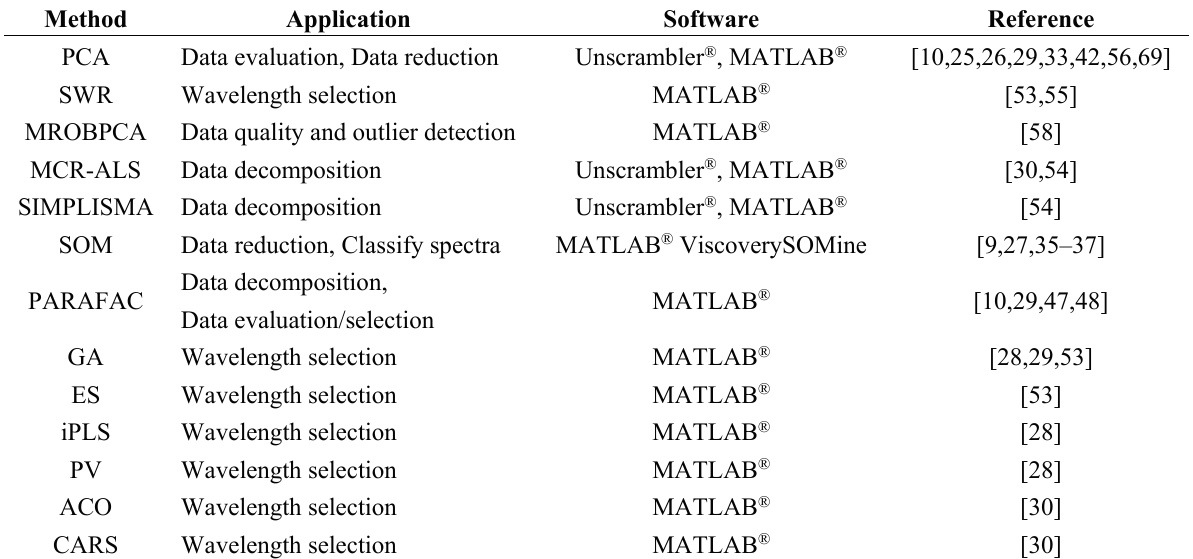
Table 4. Methods for data reduction, decomposition and wavelength